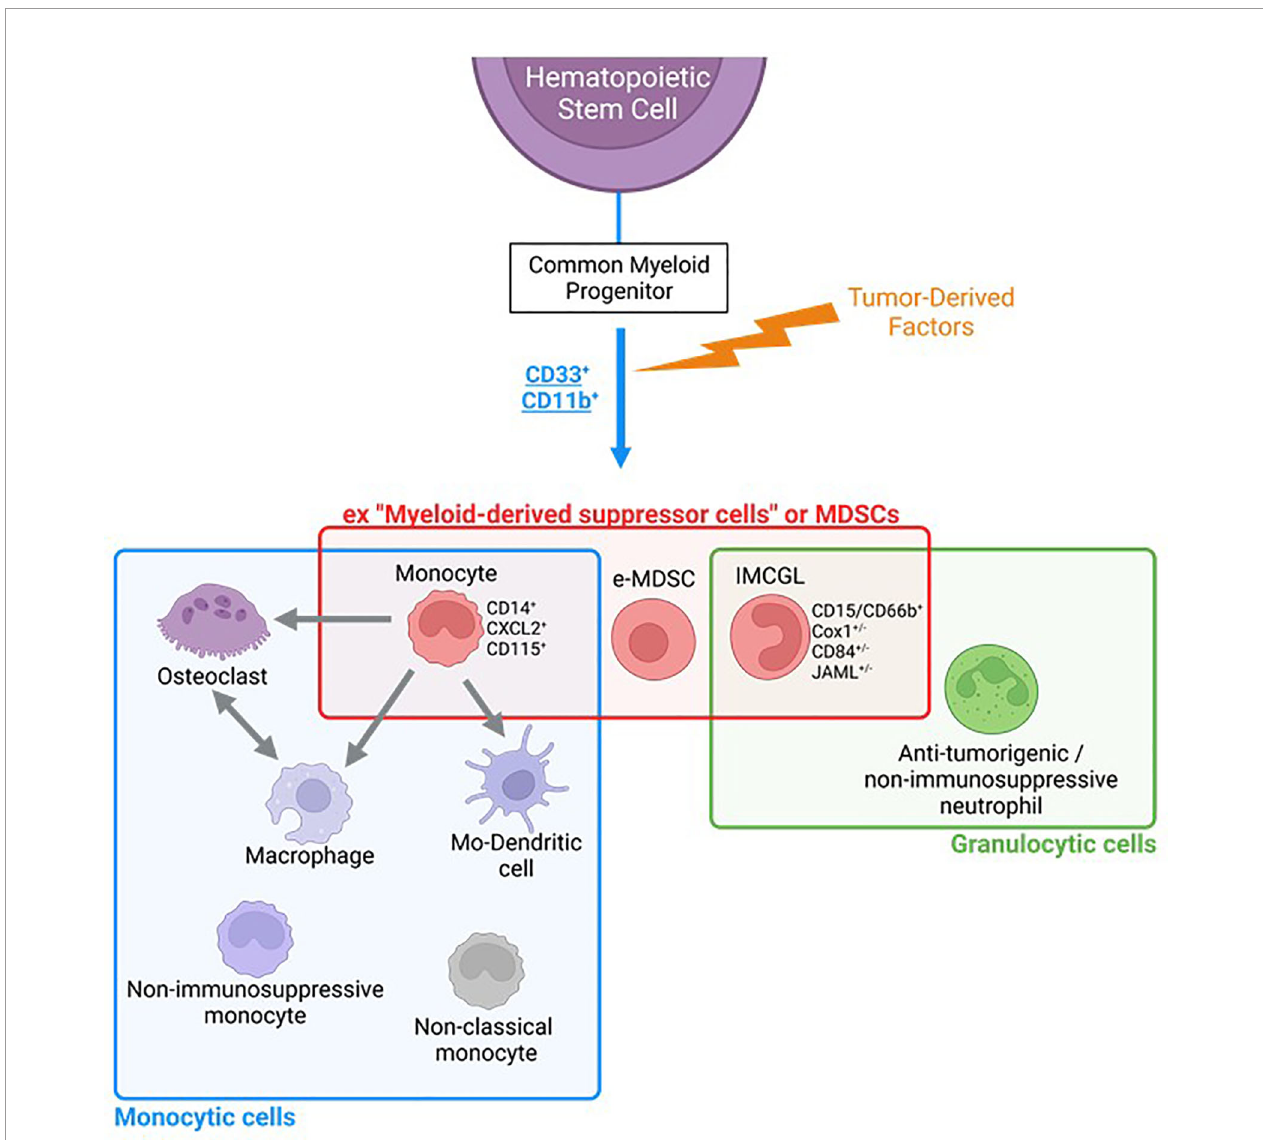
FIGURE 2 | Overlaps between subsets of tumor-promoting myeloid cells (monocytic vs gralulocytic origine). Cells formerly referred to as “ Myeloid-Derived Suppressor Cells, MDSCs ” encompass undifferentiated CD33 + CD11b + ( “ early-MDSCs ” ), immunosuppressive cells of the granulocytic lineage that we propose to call “ immunosuppressive Myeloid Cell of the Granulocytic lineage, IMCGL ” ( “ formal PMN-MDSCs ” ), and monocytes endowed with pro-tumoral properties. These tumor- promoting monocytes ( “ formal m-MDSCs ” ) can differentiate into pro-tumoral macrophages, Mo-dendritic cells or osteoclasts, each endowed with multiple dedicated tumor-promoting activities. IMCG, immunosuppressive myeloid cells from granulocytic lineage; e-MDSCs, early-myeloid-derived suppressor cells; Mo-Dendritic cell, monocyte-derived dendritic